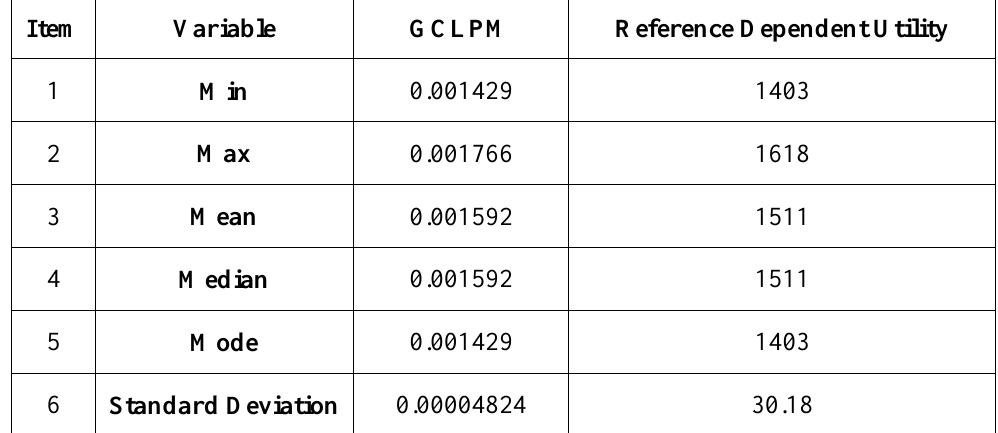
Table 6. Result Specification of Scenario 2 in First